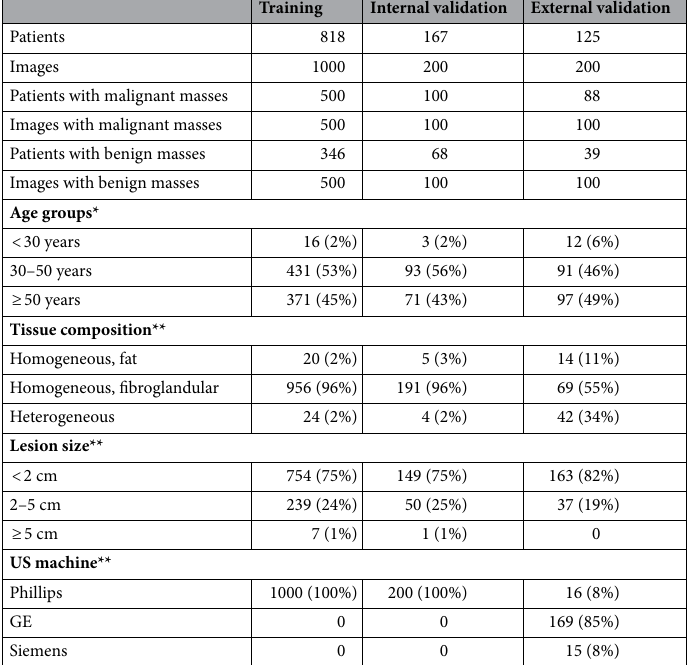
Fully-supervised P values Weakly-supervised Manual Automated